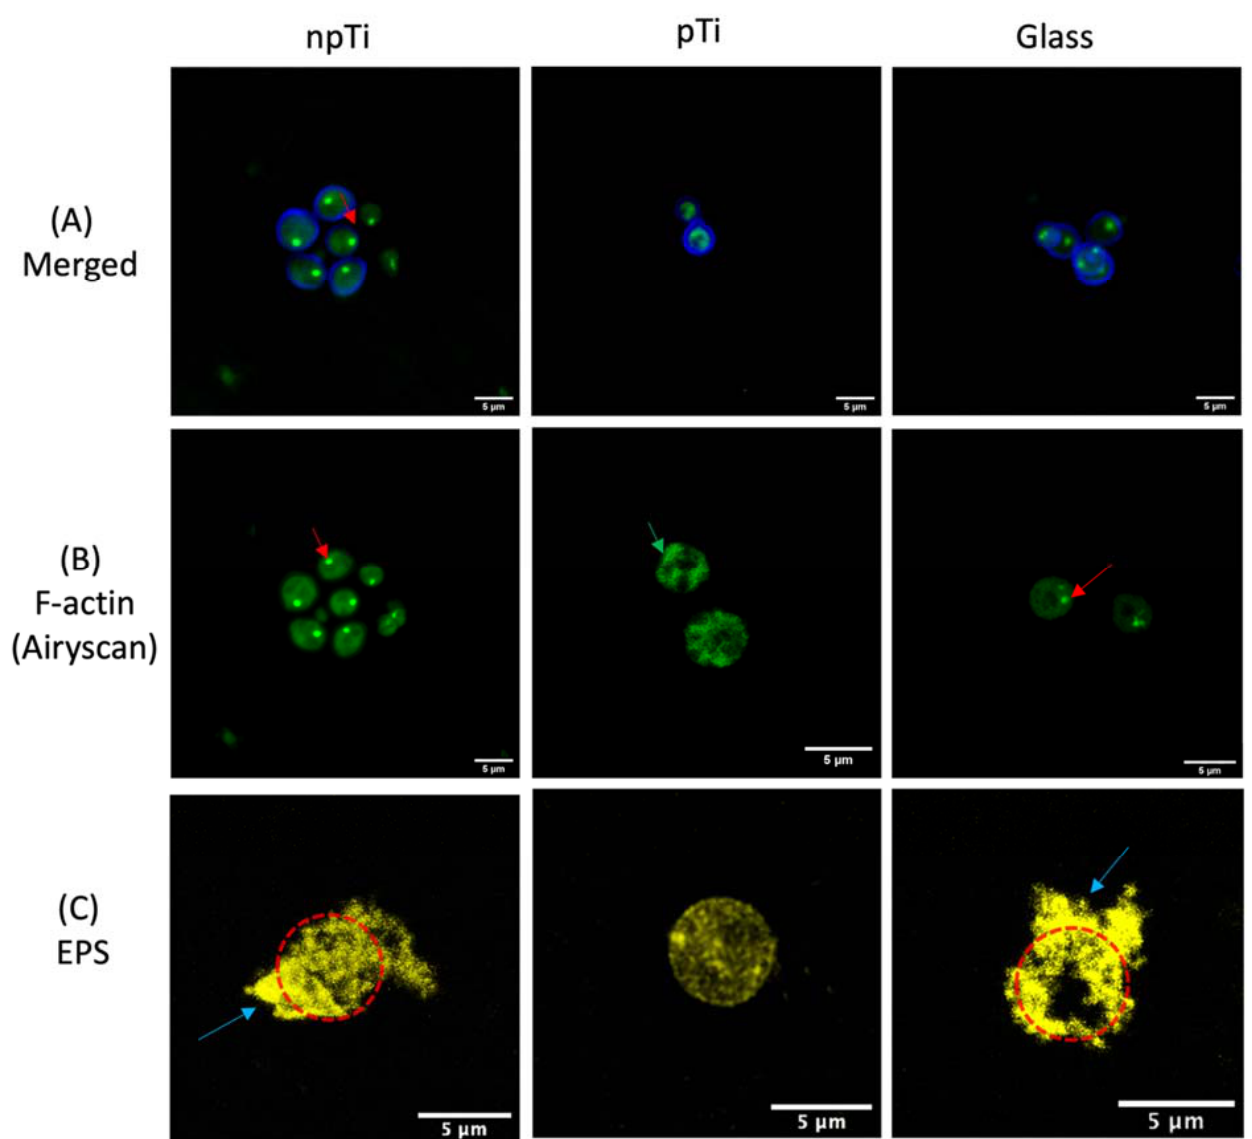
Figure 4. Cell wall, F-actin staining, and EPS production of C. albicans attached on npTi, pTi, and glass surfaces after a 3-day incubation period. ( A ) CLSM micrographs of C. albicans cells stained with calcofluor white (blue color) and phalloidin, which selectively stains F-actin (green color). ( B ) High-resolution CLSM (Airyscan) micrographs of filamentous actin distribution of C. albicans cells on the three studied surfaces. The red arrow indicates representative actin patches. The green arrow shows the lack of actin patches and the condenses in F-actin distribution of attached cells on pTi. ( C ) C. albicans cells were stained with Concanavalin A, which specifically binds to the a-mannopyranosyl and a-glucopyranosyl glycoprotein components of EPS (yellow). The EPS formed by the C. albicans was developed on npTi and glass surfaces after a 3-day incubation period. The blue arrow indicates the EPS surrounding attached cells on npTi and glass. The cell body was detected underneath the EPS, indicated by the red dashed circle. By contrast, attached cells on pTi were not enclosed by any EPS. Scale bars are 5 µm.